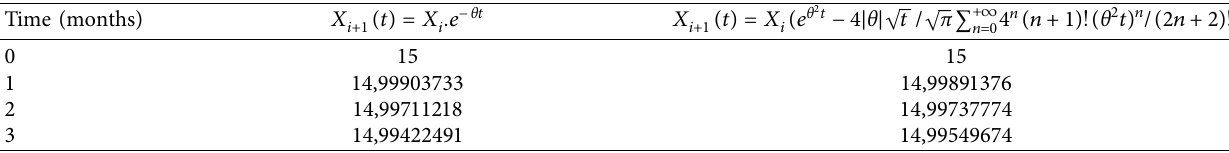
Table 1: Evolution of the quantity of the contaminant over